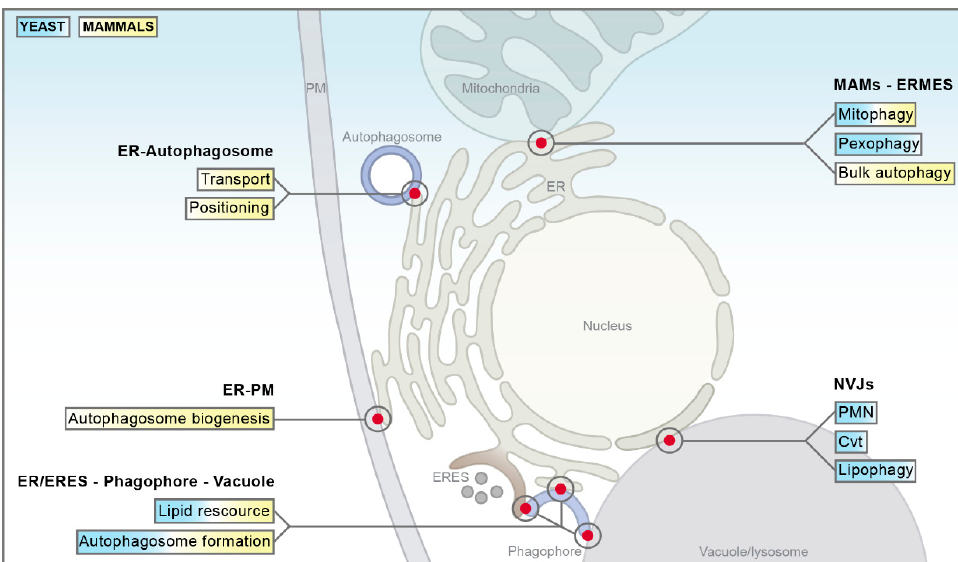
Figure 5. Summary of membrane contact sites involved in the regulation of autophagy. The main contribution of each interorganellar contact site to the autophagic process is shown in yeast (blue) and mammals (yellow). Please see main text for a detailed description. ER = endoplasmic reticulum; PM = plasma membrane; ERES = ER exit sites; MAMs = mitochondria-associated membranes; ERMES = ER–mitochondria encounter structure; NVJs = nucleus–vacuole junctions; PMN = piecemeal microautophagy of the nucleus; Cvt = cytoplasm to vacuole